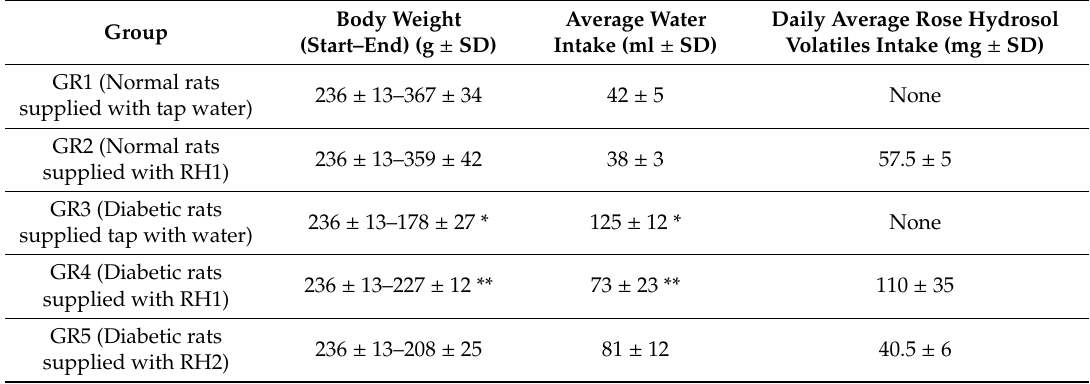
Table 1. Experimental groups, treatment type, body weight, 45 day average water intake, and 45 day average rose hydrosol volatile consumption.